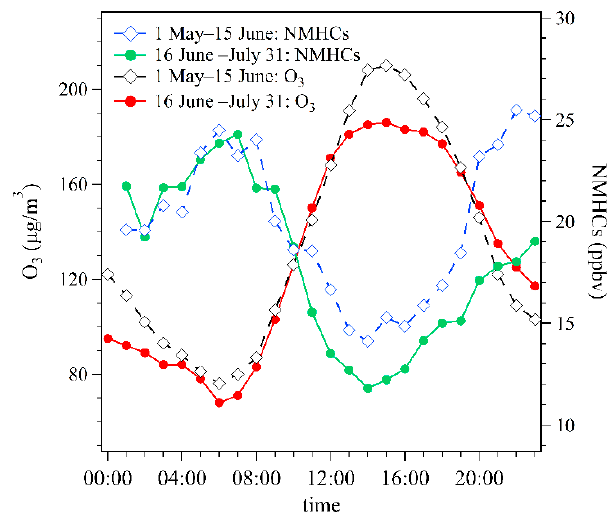
Figure 6. Average diurnal variation patterns of hourly average O 3 concentrations and NMHCs